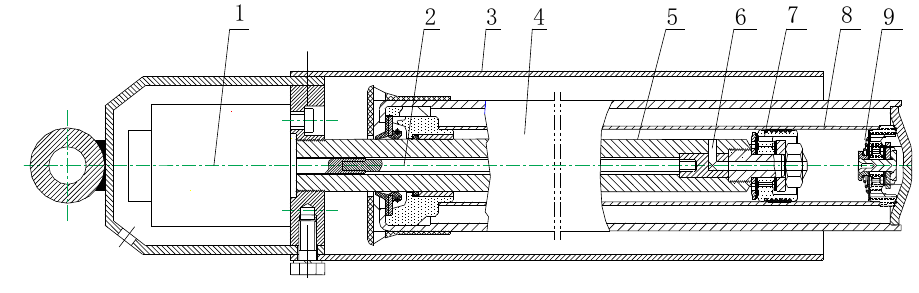
Figure 2. The controllable hydraulic damper.